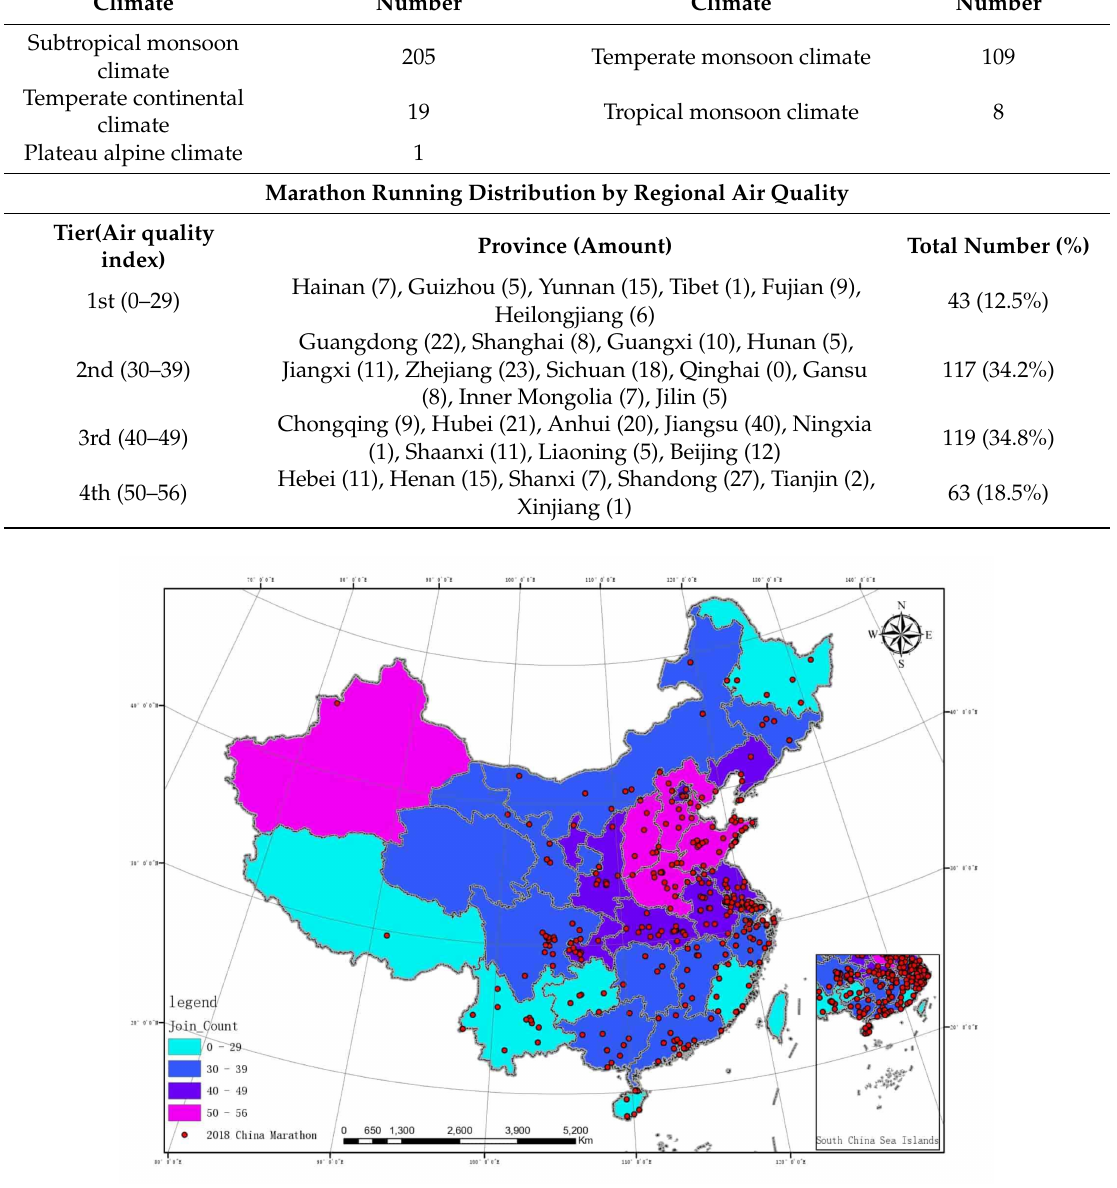
Figure 4. Air quality and marathon running coupling